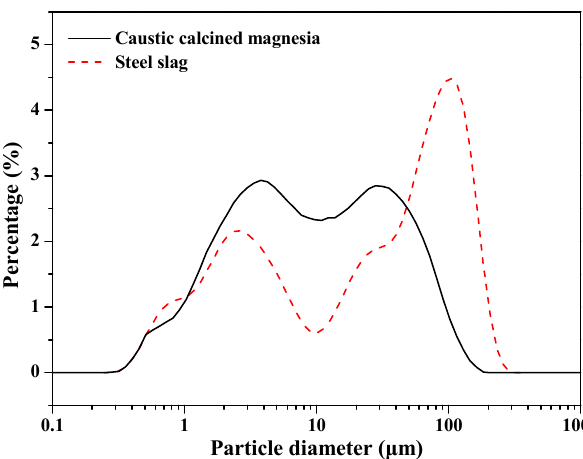
Figure 1. Particle size distributions of the caustic calcined magnesia and steel slag used in this research. Table 1. Chemical compositions and physical properties of caustic calcined magnesia and steel slag. Content (wt.%)